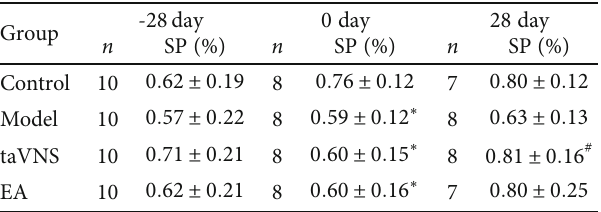
At 0day, two rats were removed from each group. At 24 day, two rats from the control and EA groups died when experimenters took blood from the caudal vein. ∗∗∗ P < 0 : 001 , vs. the control group; ∗∗ P < 0 : 01 , vs. the control group; ∗ P < 0 : 05 , vs. the control group; # P < 0 : 05 , vs. the model group. Table 2: Comparison of sucrose preference in each group at di ff erent time points ( (cid:1) x ± s